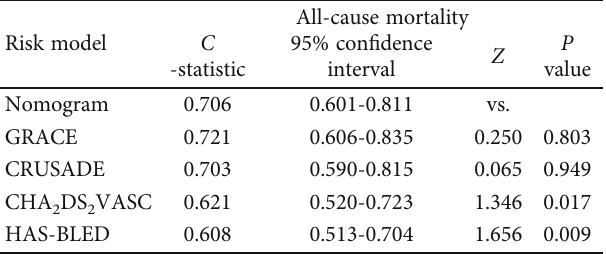
Figure 4: ROC curve of the GRACE, CRUSADE, CHA HAS-BLED, and nomogram to predict all-cause mortality in validation Table 4: C -statistics of the GRACE, CRUSADE, CHA HAS-BLED, and nomogram to predict all-cause mortality and comparisons of the predictive accuracy of the risk scores for all- cause mortality by DeLong test in validation cohort.